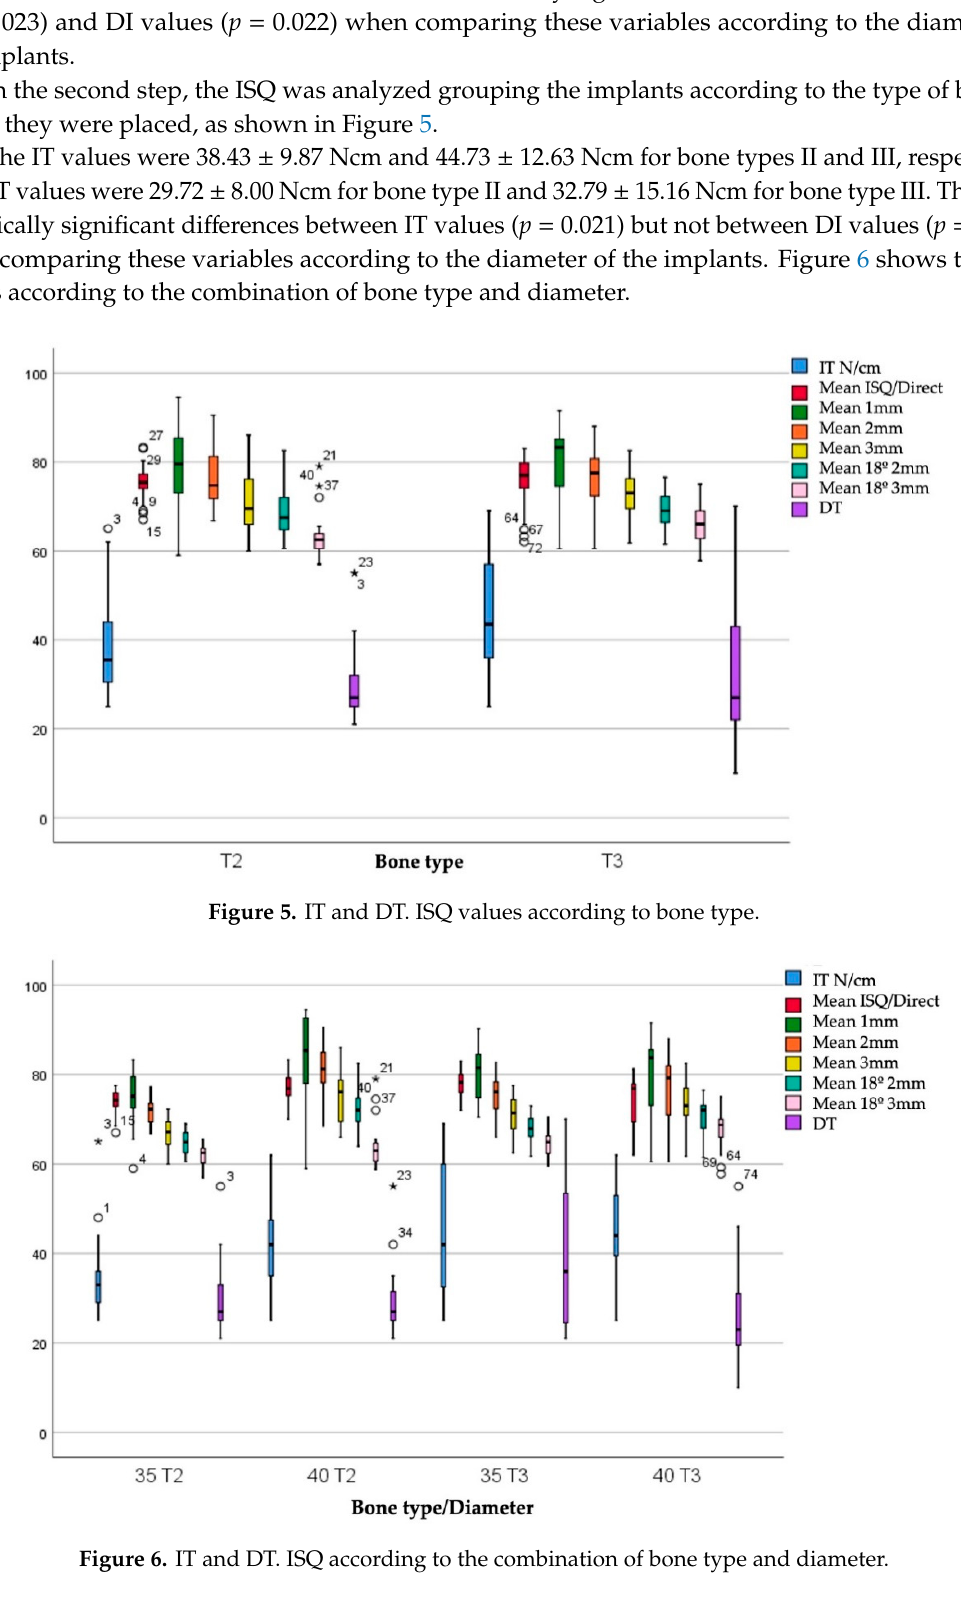
Figure 6. IT and DT. ISQ according to the combination of bone type and diameter.